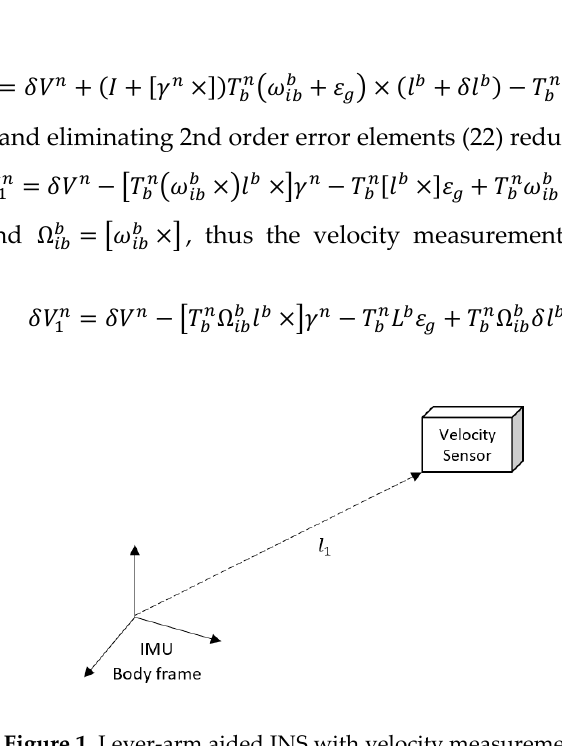
Figure 1. Lever-arm aided INS with velocity